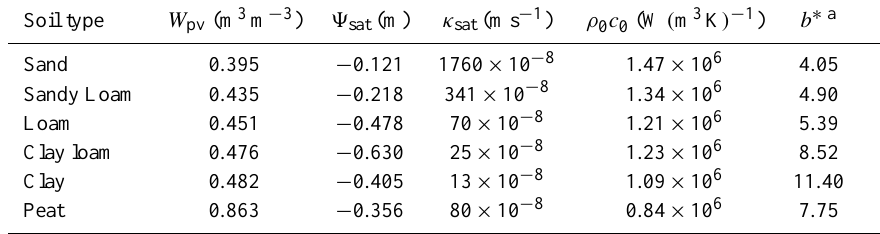
Table B2. Soil parameters as used in Pielke (1984) (adapted from McCumber,